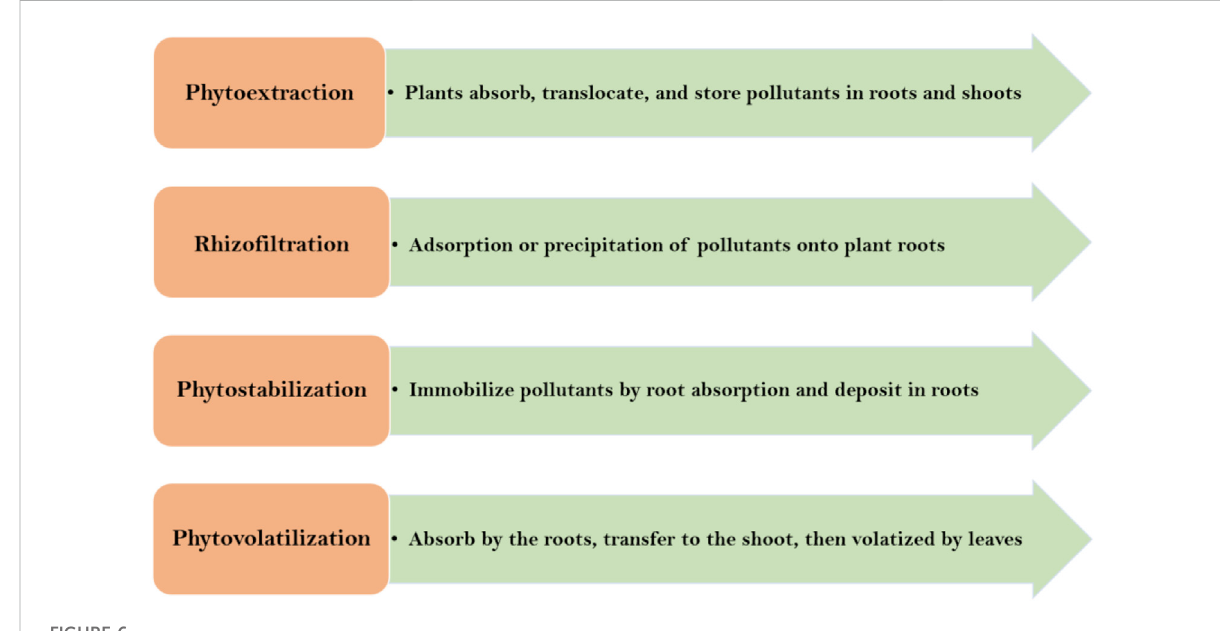
FIGURE 6 Phytoremediation techniques for metal(loid)s